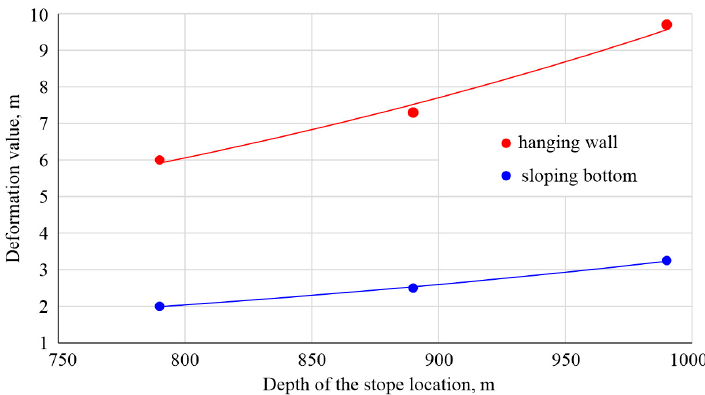
Figure 8. Dependence of the change in the deformation value of the hanging wall mass and ore mass near the sloping bottom with an increase in the depth of mining.